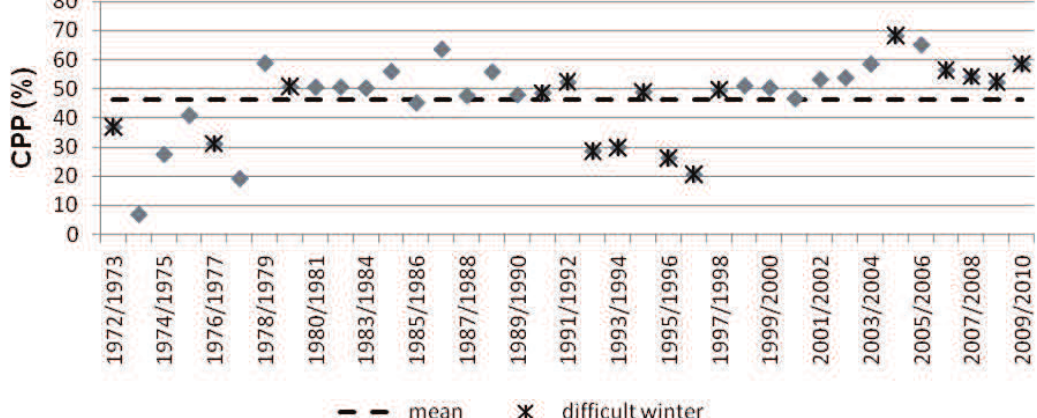
2009/2010.Figur e 2. The annual and mean calf production percentage (CPP) in the Muonio reindeer herding district during 1972-2010. Winters experienced as difficult by the reindeer herders are marked with